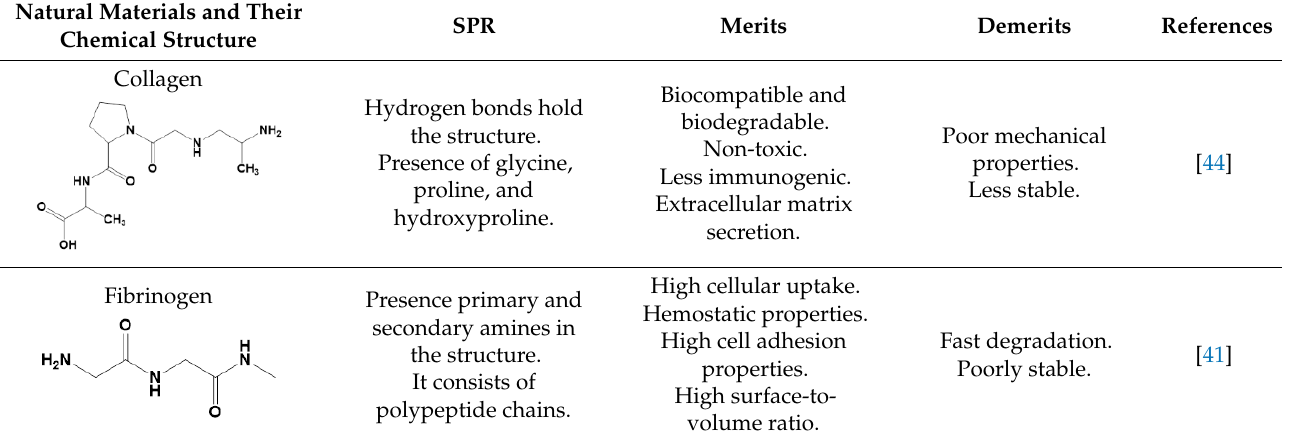
Table 1. Natural materials used to prepare 3D scaffolds.